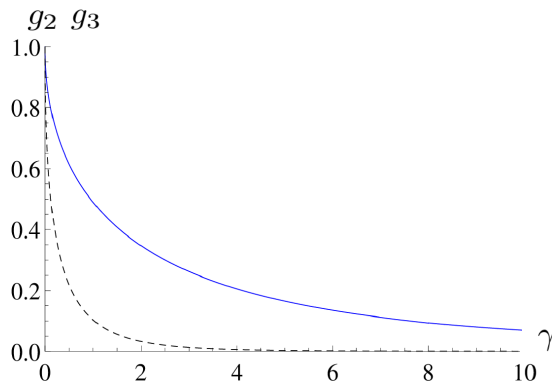
(blue, solid) from Eqs. (10) and (24) and 2